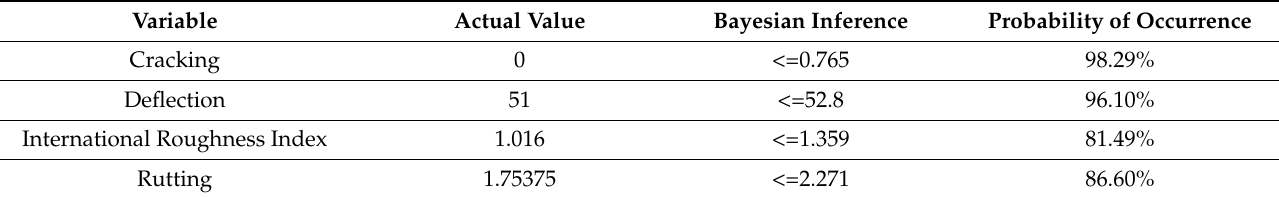
Table 8. Actual value and Bayesian value for the test datapoint